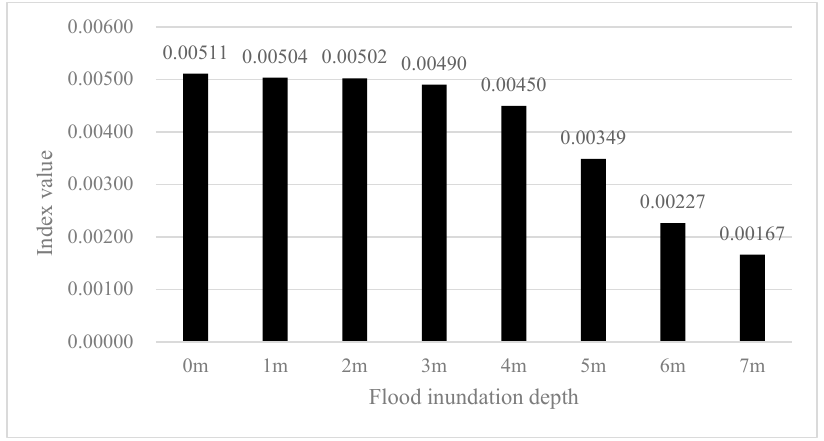
Figure 7. Analysis results of the road network equalization for the study area (Source: self-drawn by the author).